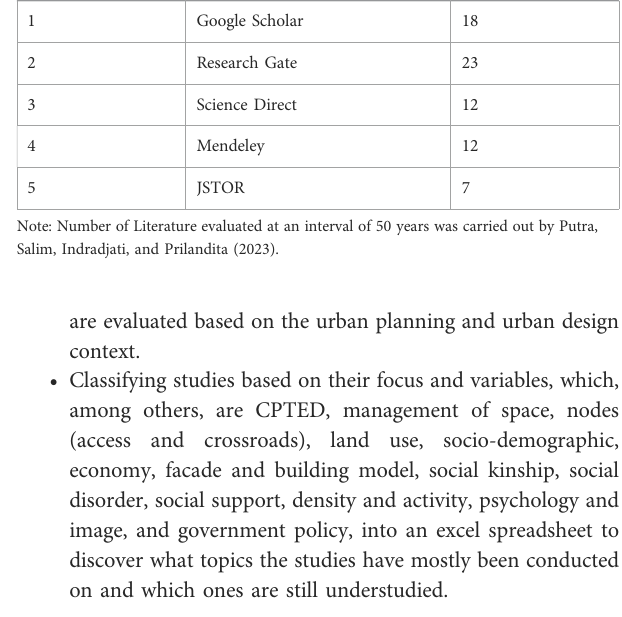
TABLE 1 Number of analyzed articles based on the sources.